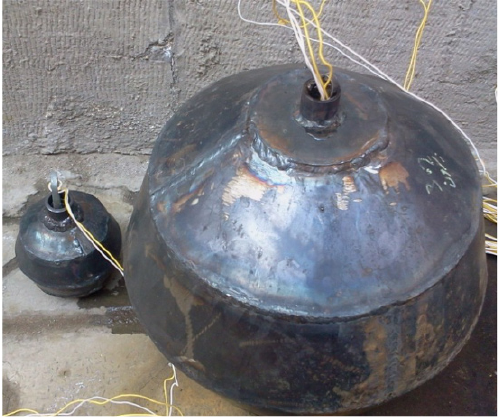
Figure 6. Explosive charge and associated rods installed inside ves- sels.